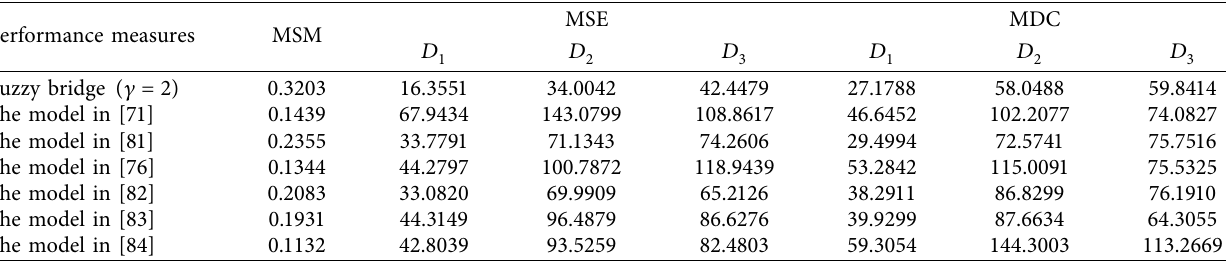
Table 5: Performance measures of the proposed fuzzy bridge regression model for c � 2 and some common fuzzy regression models in Example